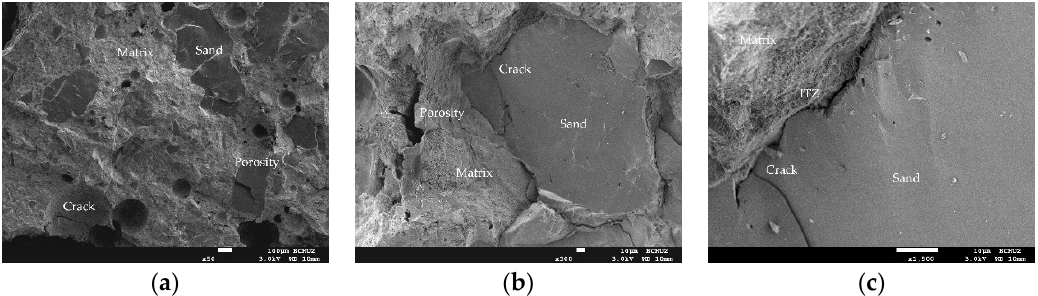
Figure 15. SEM observations of the HSC sample at room temperature: ( a ) 50× magnification, ( b ) 300× magnification, and ( c ) 1500× magnification.